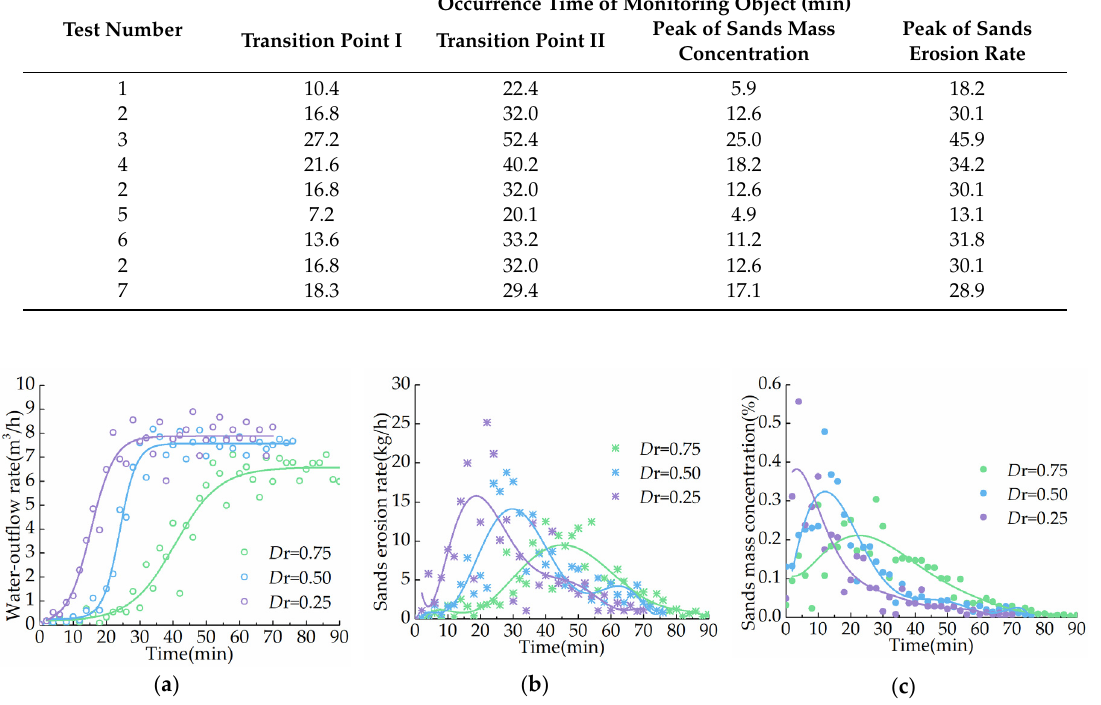
Table 6. Occurrence time of transition points and peak value of monitor objects.